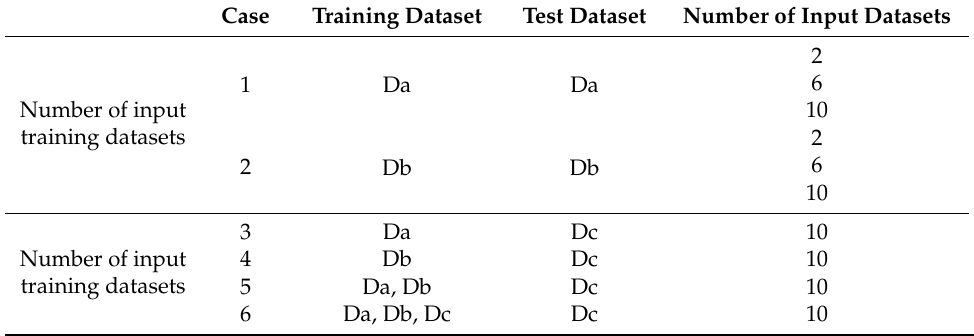
Table 1. Comparison of prediction results for each